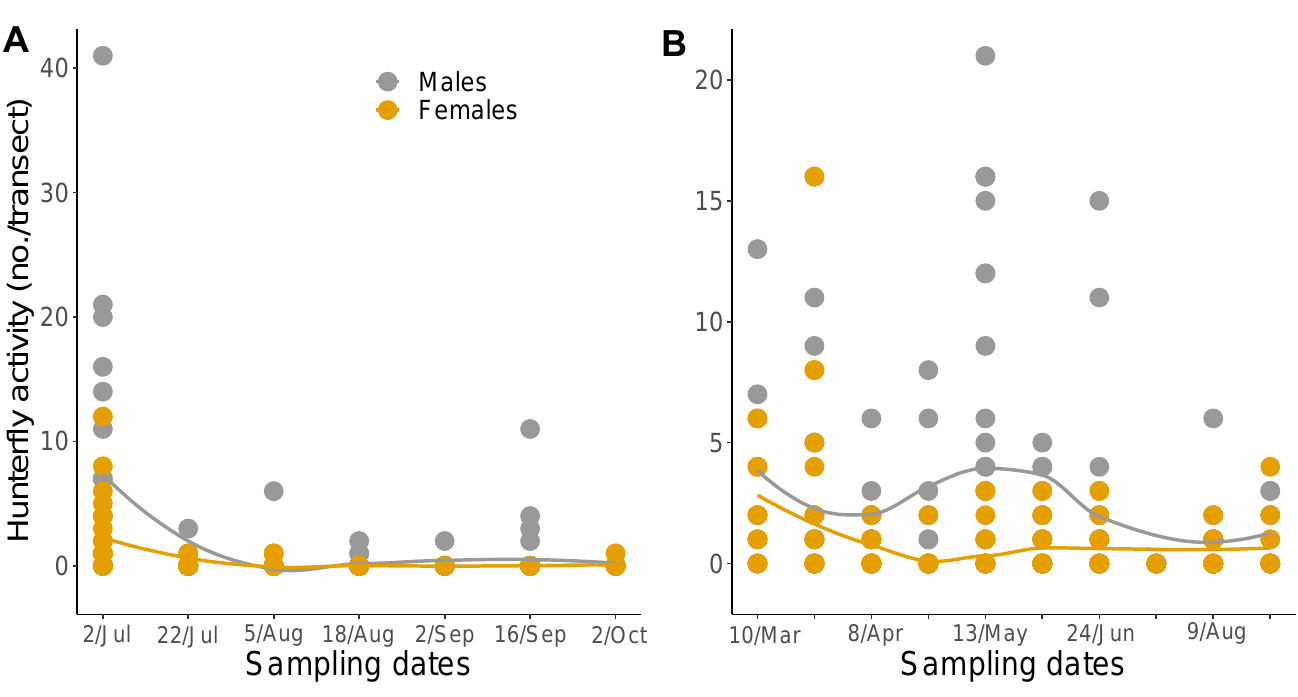
Figure 3. Seasonal summary of mean counts of Coenosia attenuata observed in pan traps combined by transect for ( A ) 2020 and ( B ) 2021. Line color indicates: Male = gray, Female = gamboge. Data points represent the mean sum total of hunter flies captured in blue, white, and yellow pan traps for a total of nine traps per field. The solid lines are loess smoothing curves with corresponding shaded 95% CI to display the estimated fluctuation in captures over the season.